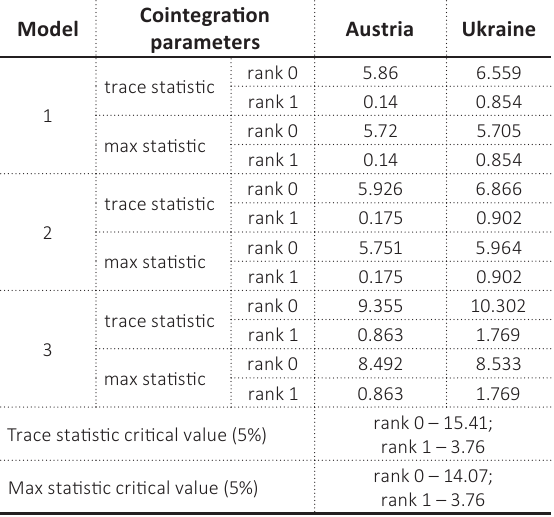
Table 11. Results of the Johansen cointegration test: the case of Ukraine and Austria